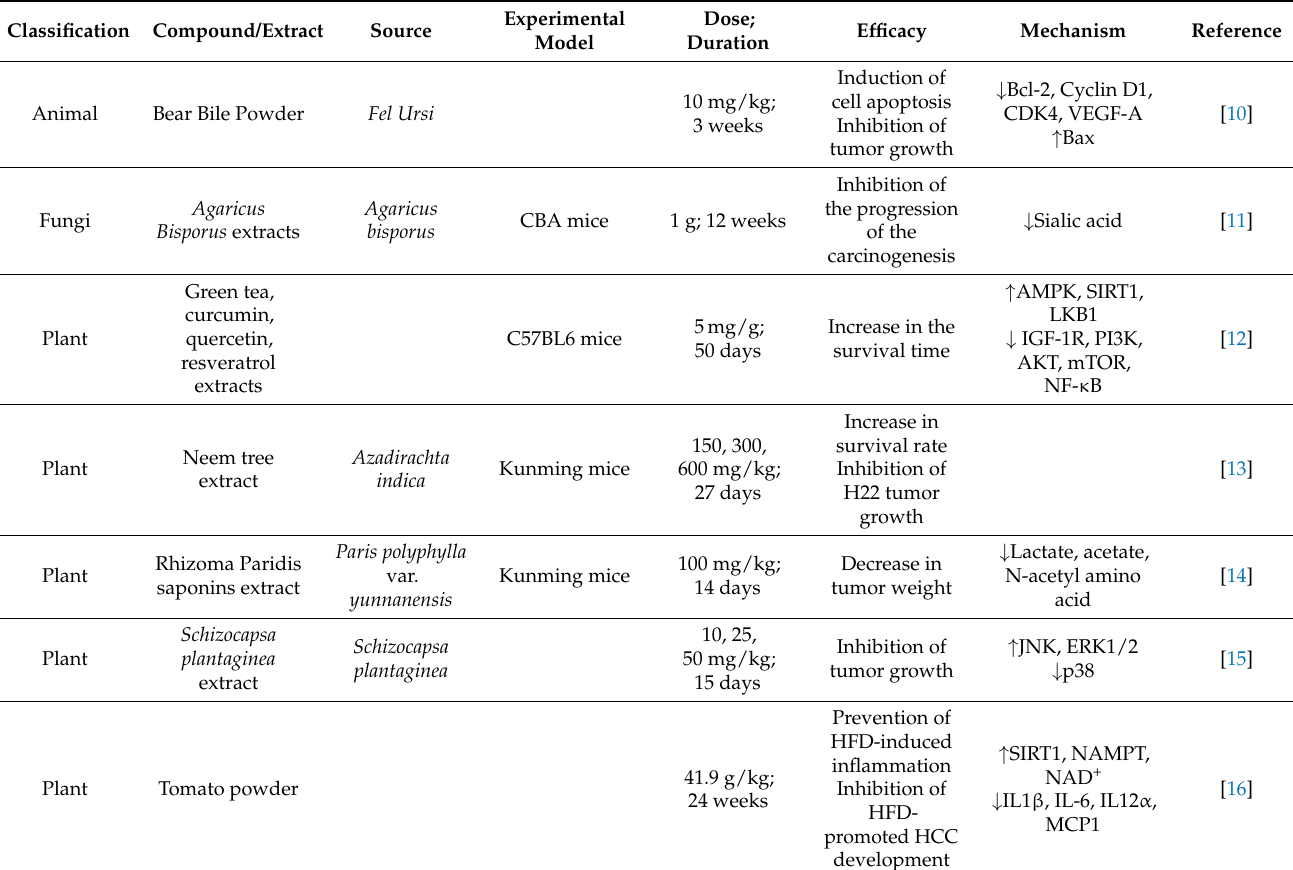
Table 1. In vivo